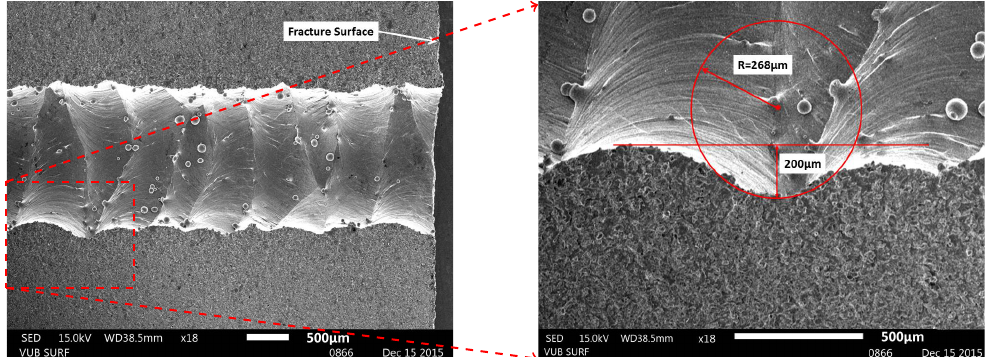
Figure 13. Longitudinal cut view of the surface roughness of the printed capillary of Specimen 9: ( a ) a general overview and ( b ) a detailed view with derived dimensions as input for the